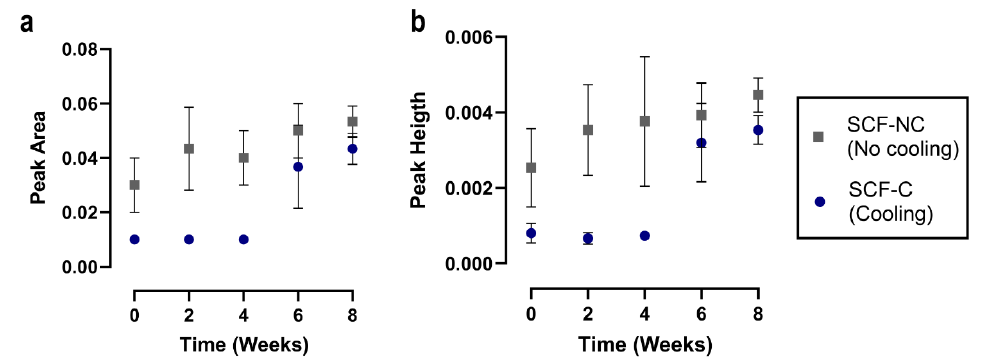
Figure 7. Peak area at 921 cm − 1 during the immersion period. ( a ) A constant increment was observed for the SCF-NC group. For the SCF-C group, the increase was evident until week 6. ( b ) Similar behavior and increments were observed in the peak height. At the end of the experiment, the peaks showed increments of 76% and 136% for the SCF-NC and the SCF-C groups, respectively.